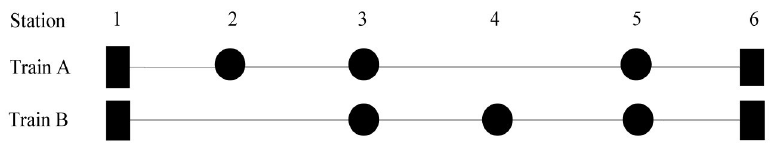
Figure 1. Train stop schedule for basic sinario in case